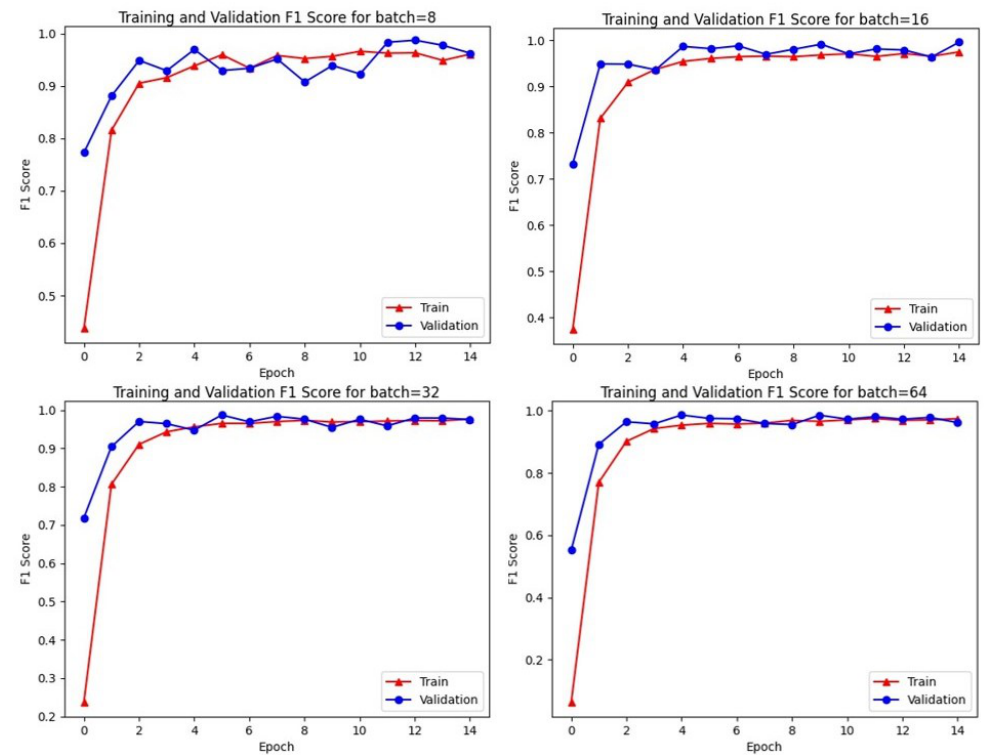
Figure 5. Model learning rate performance on different batch